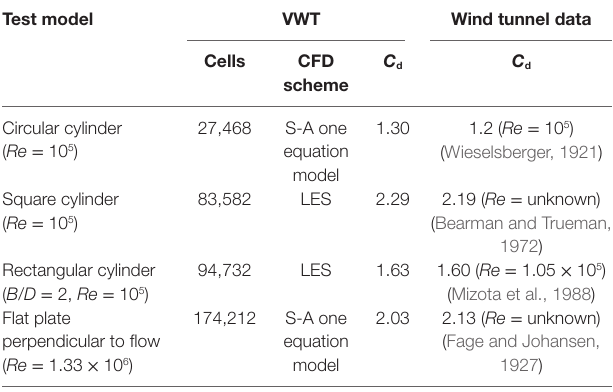
TaBle 2 | Drag coefficient of various